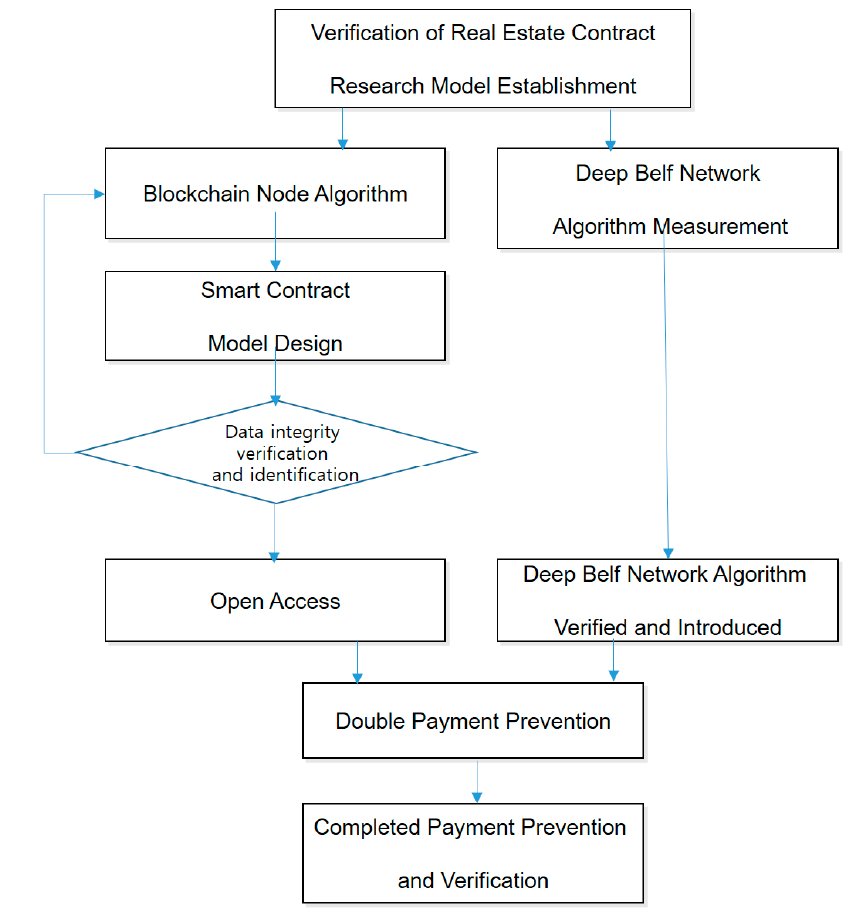
Figure 4. Research plan for real estate.